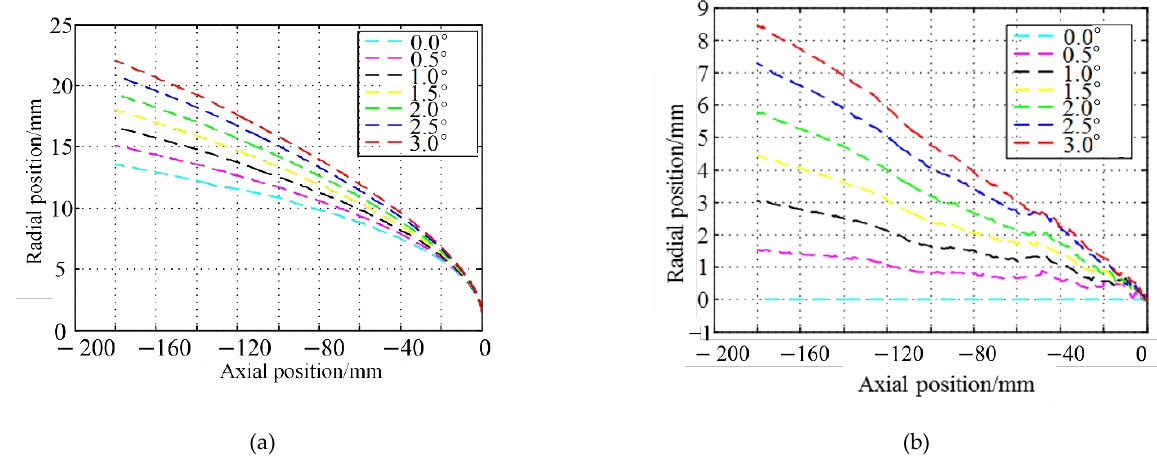
Figure 12. ( a ) Upper half of the cavitation shape at different attack angles (v = 300 m/s). ( b ) The offset of the cavitation axis in the longitudinal plane at different angles of attack (v = 300 m/s).